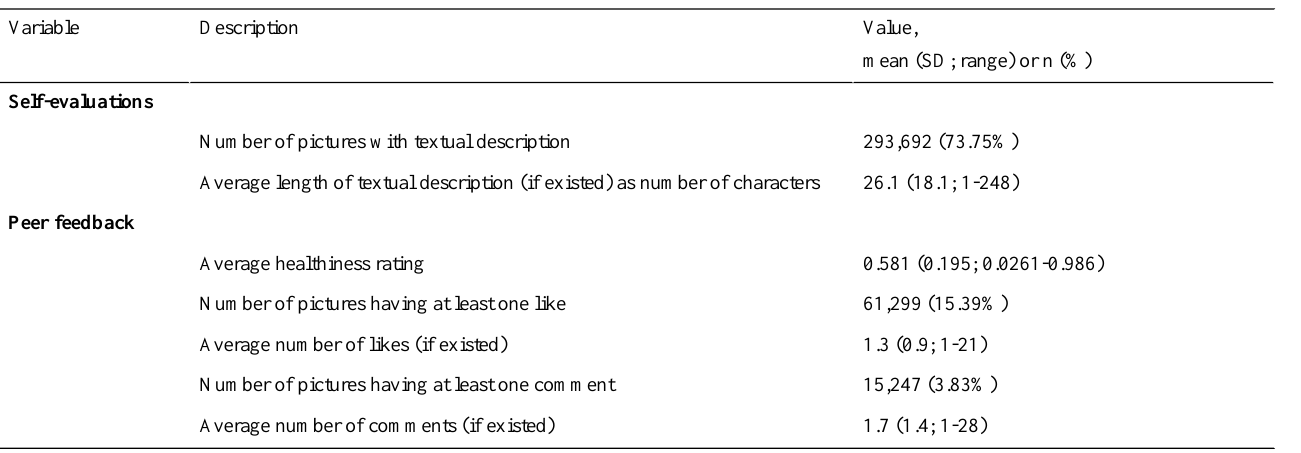
Table 4. Statistics for the 398,228 valid pictures taken by 58,769 users of the dietary self-monitoring app “The Eatery”.